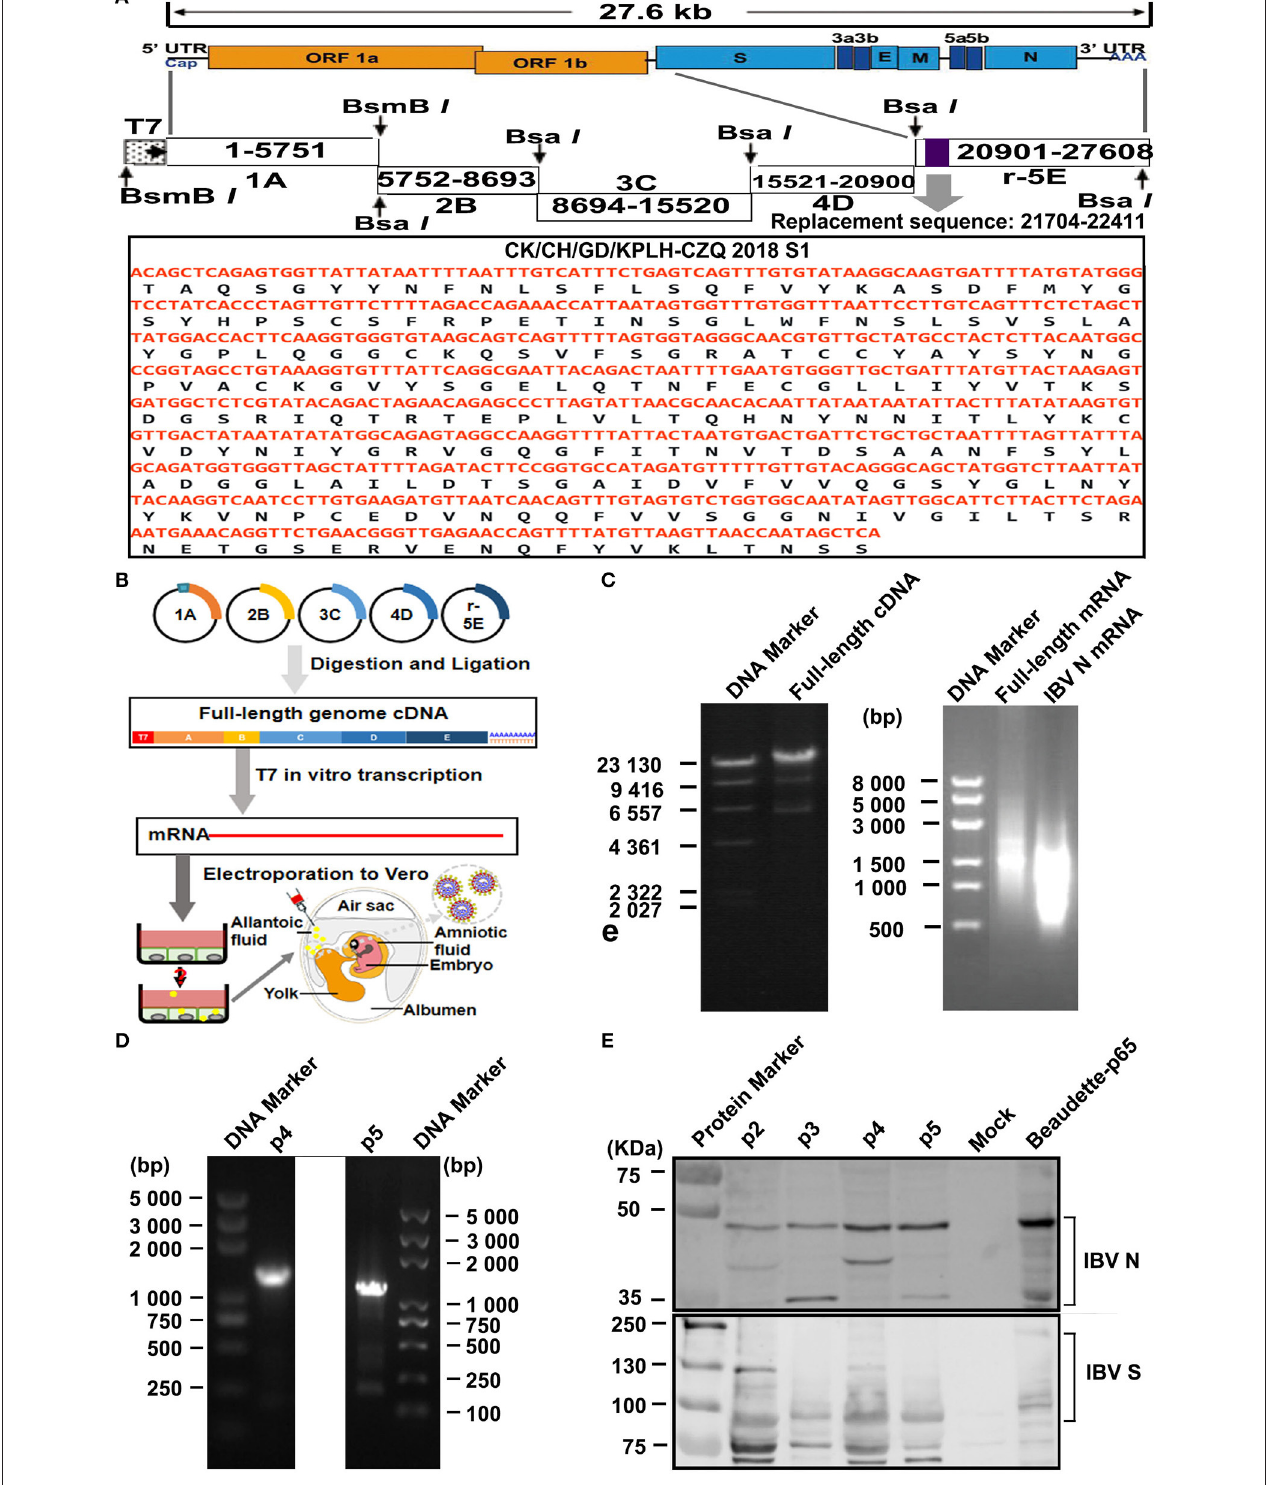
FIGURE 1 | Construction and rescue of rIBV-Beau-KC(S1). (A) Diagram showing the genome organization of rIBV-Beau-KC(S1). The regions coding for the replicase polyproteins; the structural proteins S, E, M, and N; the accessory proteins 3a, 3b, 5a, and 5b; and the 5 ′ - and 3 ′ -UTR are shown. Also shown are the regions of the five RT-PCR fragments, the T7 promoter at the 5 ′ -end of fragment A, the 30 As at the 3 ′ end of fragment E, and the replacement region of S1 at nucleotides